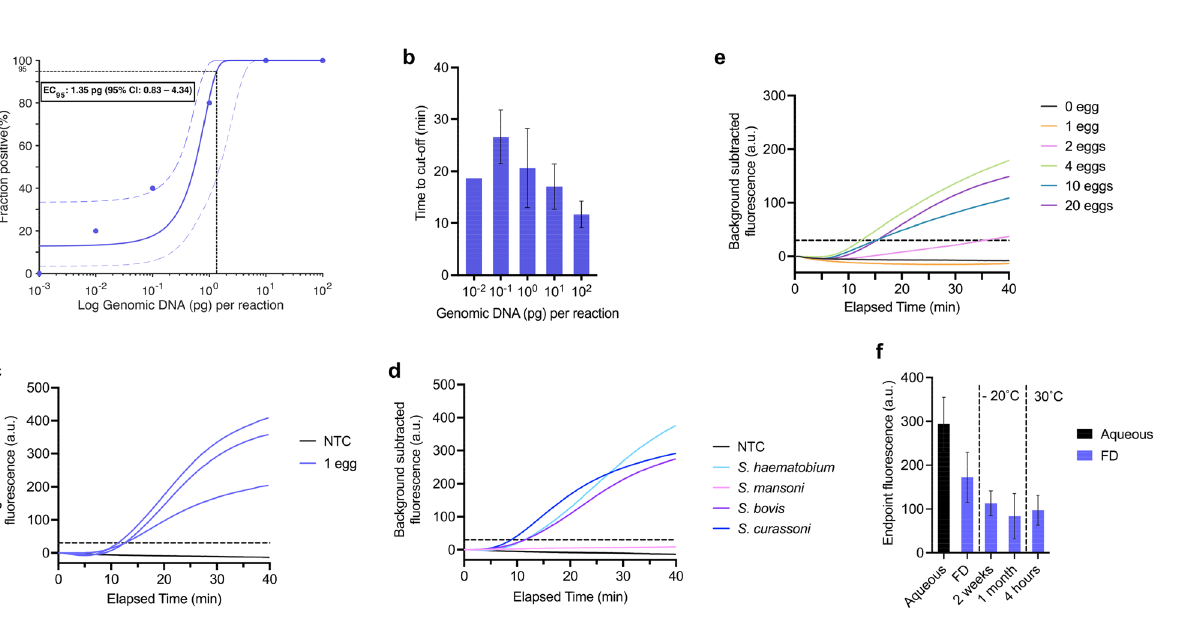
Figure 2. Evaluation of CATSH. ( a ) Calculation of analytical sensitivity (EC 95 ) with genomic DNA using the fraction positive (dots) calculated with five replicates for each concentration tested. The Probit regression was plotted with the 95% confidence interval (dashed lines). ( b ) Time to cut-off for positive reactions. Bars represent the average time to cut-off and error bars represent the standard deviation between positive reactions. ( c ) Detection of a single parasitic egg in spiked buffer. Three individual repeats are plotted and dashed line show the fluorescent cut-off (= 30). ( d ) Species specificity tested with S. haematobium , S. mansoni , S. bovis and S. curassoni . Individual reactions are plotted. ( e ) Detection of parasitic eggs after in-house extraction from simulated urine sample. Individual reactions are plotted. ( f ) Thermostability of freeze-dried CATSH reactions. For each condition, three repeats were carried out. Bars represent the average endpoint fluorescence and error bars represent the standard deviation between